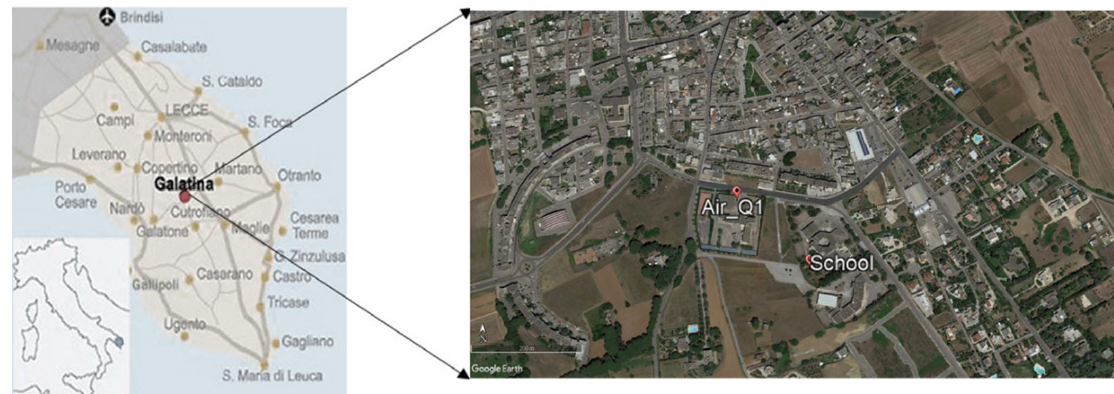
Figure 1. Area of study.